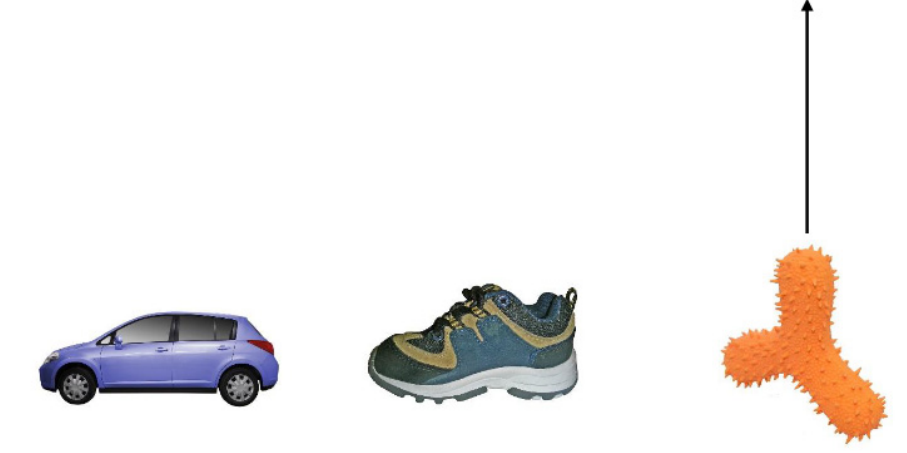
Figure 2. Example Fast Mapping Trial with Two Familiar Objects and One Novel Object. Arrow Indicates the Destination of Object During Ostensive Naming.